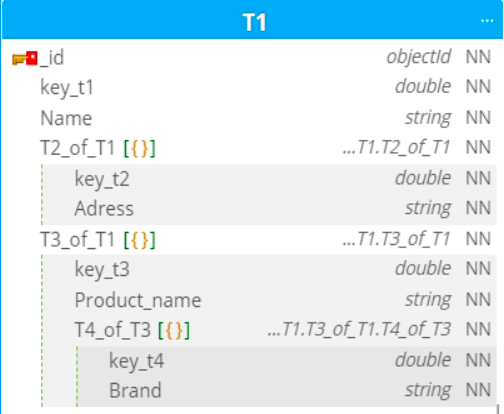
Figure 11. An example of a database of four tables.